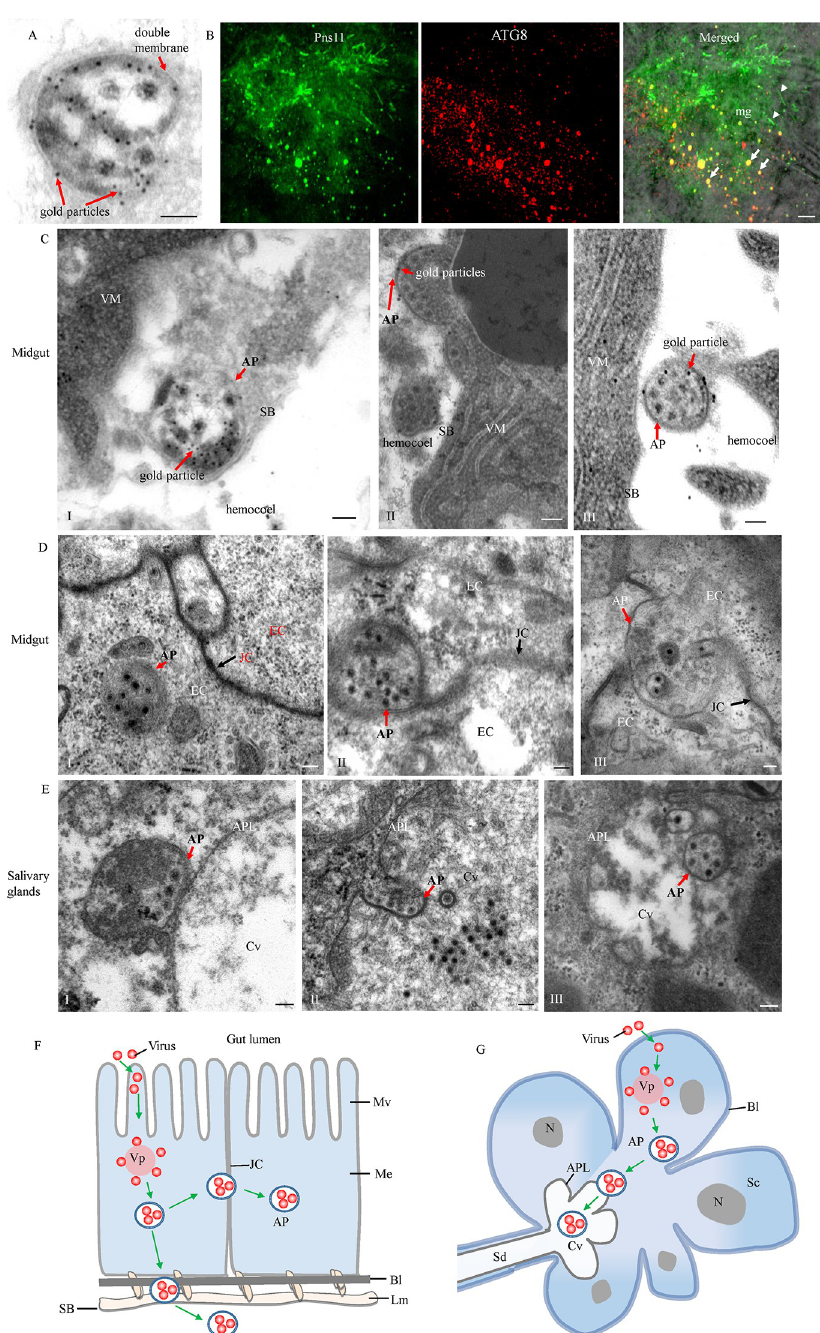
Fig 2. RGDV exploits autophagosomes to overcome insect transmission barriers. ( A ) Immunogold labeling of Pns11 in virus-containing autophagosomes. ( B ) At 6 days padp, insect intestines were immunolabeled with ATG8-rhodamine (red) and Pns11-FITC (green), and then examined by immunofluorescence microscopy. Arrows indicate the colocalization of Pns11 and ATG8 in the puncta. Arrowheads indicate the fibrillar structures of Pns11. ( C-E ) Transmission electron micrographs showing the exploitation of autophagosomes by RGDV to overcome membrane barriers in the midgut ( C and D ) and salivary gland ( E ). ( C ) Autophagosomes attached to the serosal barrier (panel I) and then released into the hemocoel (panels II and III). ( D ) Autophagosomes targeted (panels I and II) and crossed (panel III) the midgut intercellular junctional complexes. ( E ) Autophagosomes targeted (panel I) and traversed (panels II and III) the apical plasmalemma into saliva-stored cavities. Virus-infected intestines in A and C were immunolabeled with P11-specific IgG as the primary antibody, followed by treatment with 10-nm gold